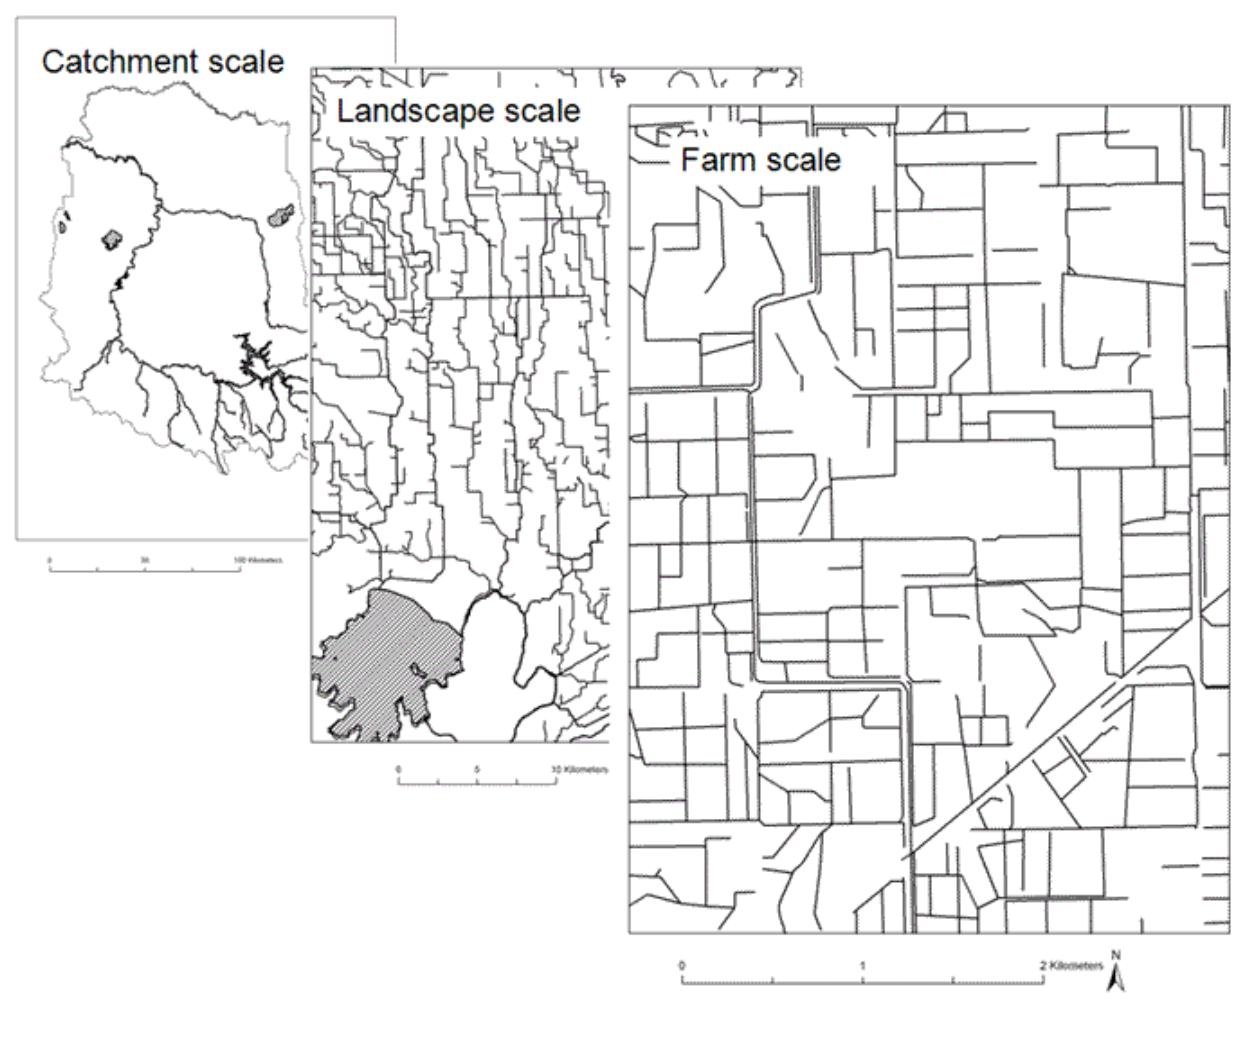
Fig. 7 . Nested structure of the irrigation infrastructure network in the Goulburn Broken Catchment. At the catchment scale, there are a small number of large dams, i.e., nodes, with sections of natural waterways and large canals, i.e., links, are used to capture and transport water. At the irrigation region, a landscape- scale network of infrastructure transfers water between temporary storages or nodes and to irrigation properties via open channels or edges. At the farm scale, the irrigation network connects intermittently to canals, i.e., the links of the landscape-scale network above, when irrigation water is required for pastures and